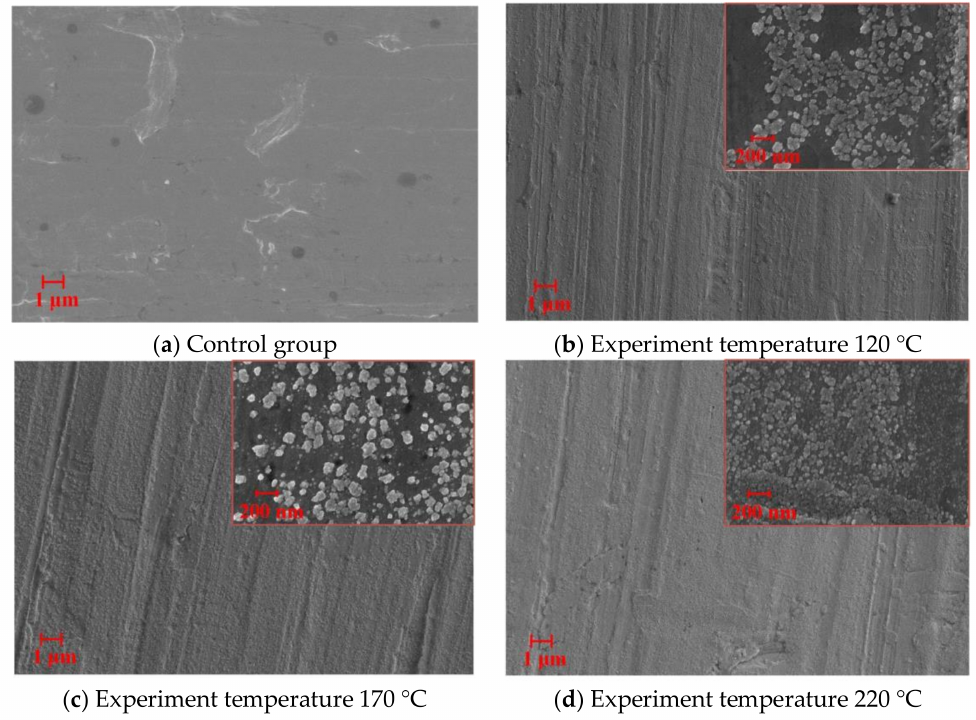
Figure 5. FESEM morphology of the surface after contact of copper with C 5 F 10 O/N 2 gas mixture.